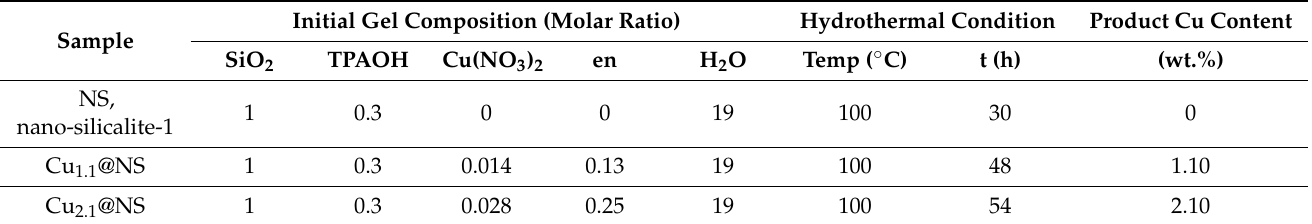
Table 1. Compositions of the synthetic batches, the crystallization conditions, and Cu contents in the